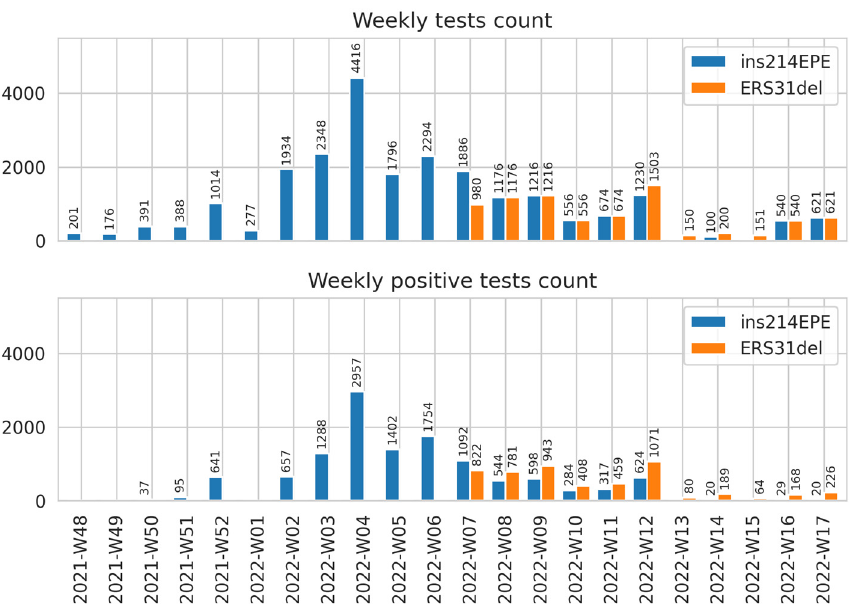
Figure 6. Samples collected in different regions of Russia during Omicron spreading were tested